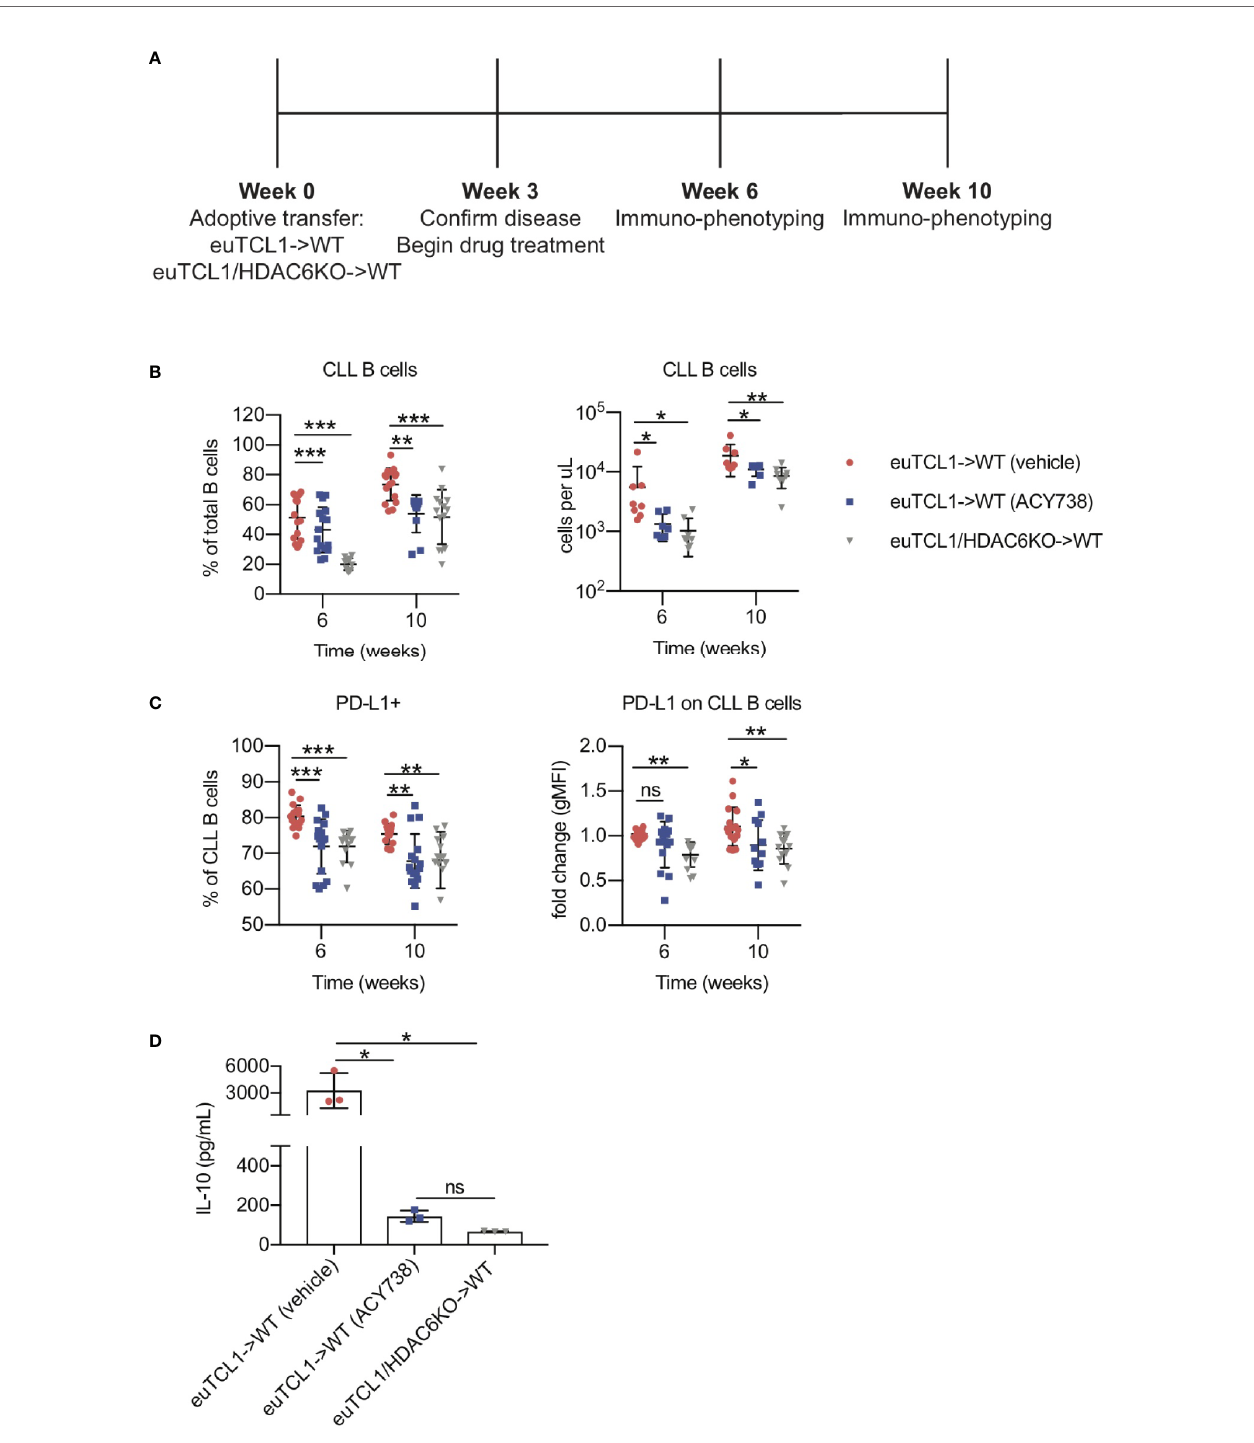
FIGURE 1 | Immunomodulatory effects of HDAC6 on CLL B cells (A) Timeline showing experimental protocol. (B) Flow cytometry to detect tumor burden in fresh murine PBMCs. CLL B cells were gated as CD3 - CD19 + B220 lo IgM hi CD5 + cells. Total B cells were gated as CD3 - CD19 + B220 + cells. (C) Percentages of PD-L1 + CLL B cells and expression of PD-L1 on CLL B cells. gMFI: geometric mean fl uorescence intensity. Percentages are compiled from 2 independent experiments, n = 12 – 14 mice per group. Counts are shown from 1 representative experiment, n = 8 mice per group. (D) Plasma was collected from submandibular bleeds and IL-10 was quanti fi ed by cytokine bead array assay, n = 3 mice per group. Graphs display mean + SD. * p < 0.05, ** p < 0.005, *** p < 0.005. ns, not signi fi